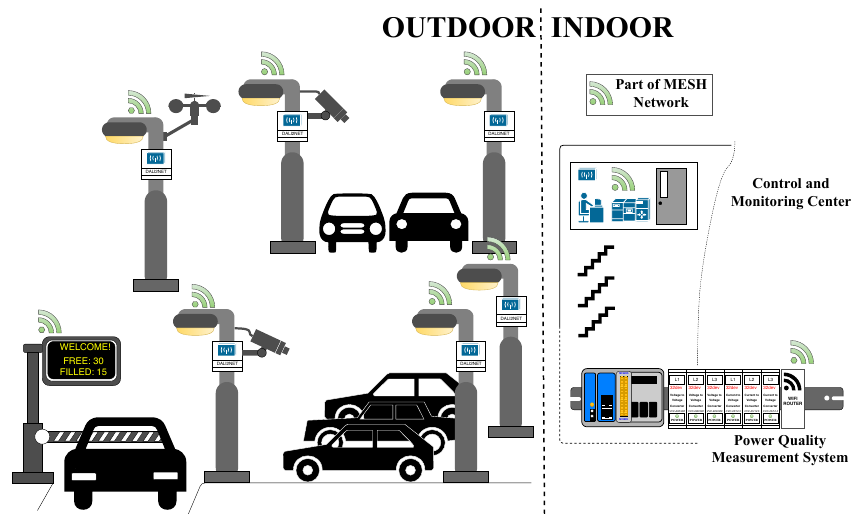
Figure 6. A simplified idea diagram of the SMART car park components deployed.